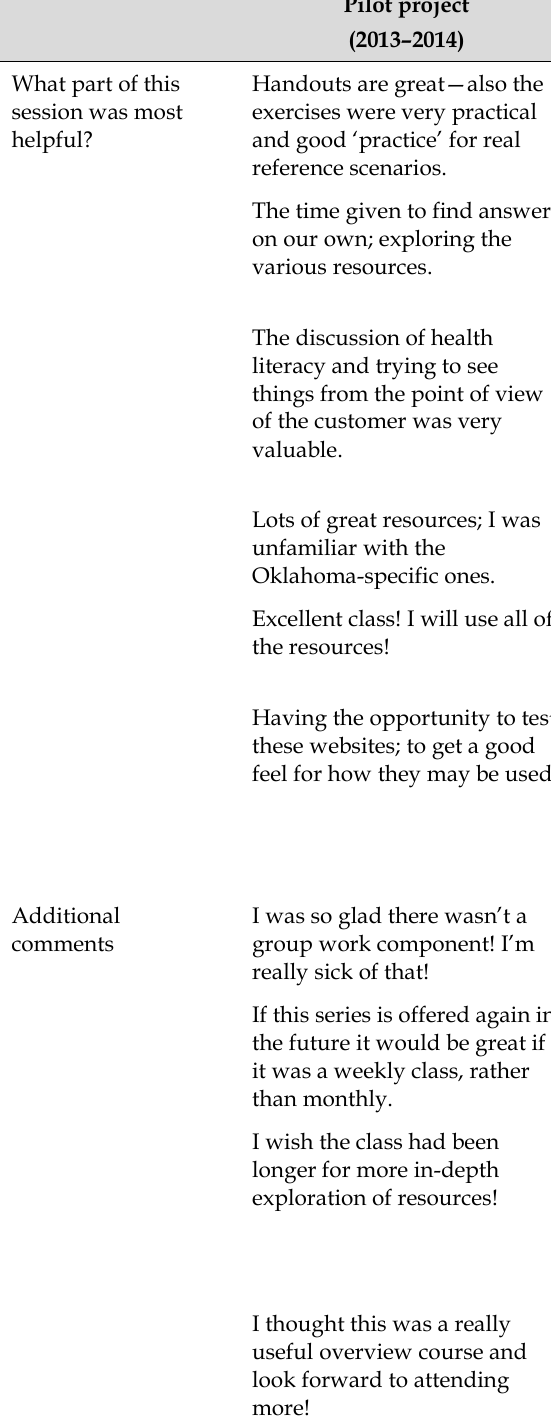
Table 4 Health Information Specialists Program: selected course evaluation comments Pilot